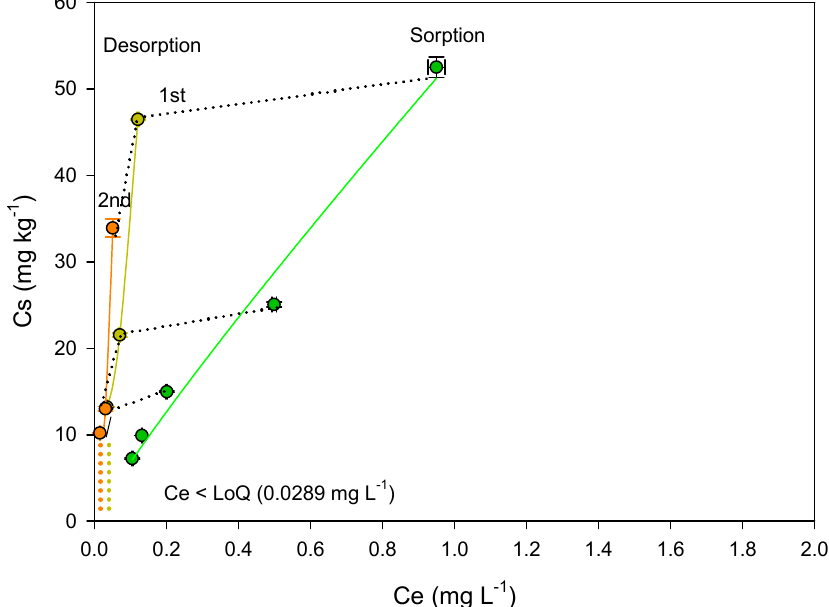
Figure 5. Sorption and desorption isotherms of metribuzin on the cellulose acetate film and the bonechar (3 g) added to water. The continuous lines in color correspond to the isotherms and the dotted ones show that no residues of the herbicide were detected (<limit of quantification (LoQ)). The vertical and horizontal bars represent the standard deviation of the means ( n = 3) of the Ce concentration at equilibrium and the Cs concentration in the sorbent, respectively. Symbols can cover the bars. Table 3. Freundlich model isotherm sorption parameters and sorption coefficients ( K d-app ) of metribuzin on pure bonechar powder and on the cellulose acetate film with